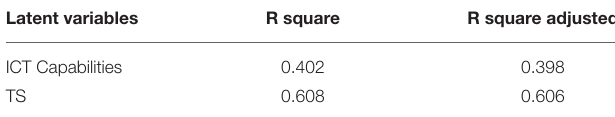
TABLE 5 | R-square value.